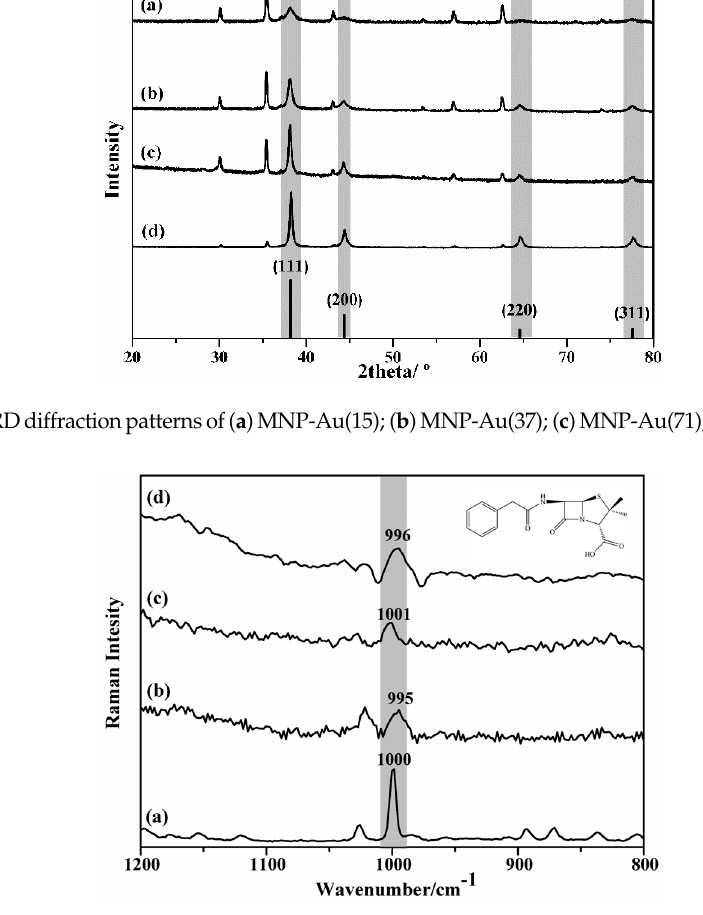
Figure 4. ( a ) Conventional Raman spectrum of PG solid; and SERS monitoring of the 1000 cm − 1 PG diagnosis band at pH 5, using a solution in the analyte with concentration 10 − 4 M: ( b ) MNP-Au(37); ( c ) MNP-Au(71); ( d ) MNP-Au(102) solid substrate (excitation line 633 nm).